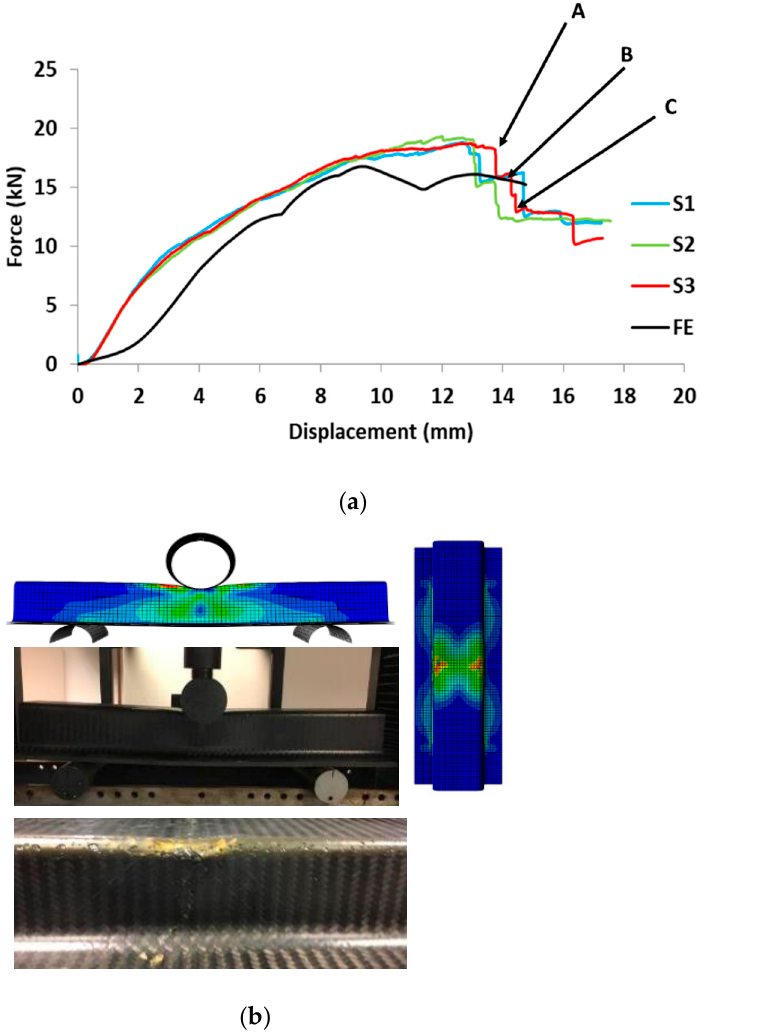
Figure 13. ( a ) Load-displacement diagram for static experimental and finite element model and ( b ) Finite element and experimental quasi-static crushing of structure .